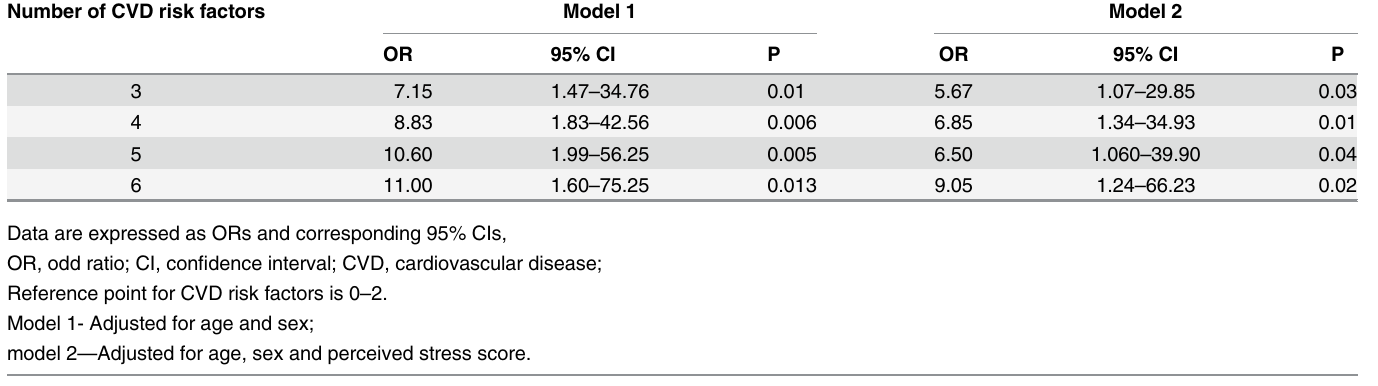
Table 5. Results of logistic regression analysis: odds ratios of plaque prevalence according to CVD risk factors. Number of CVD risk